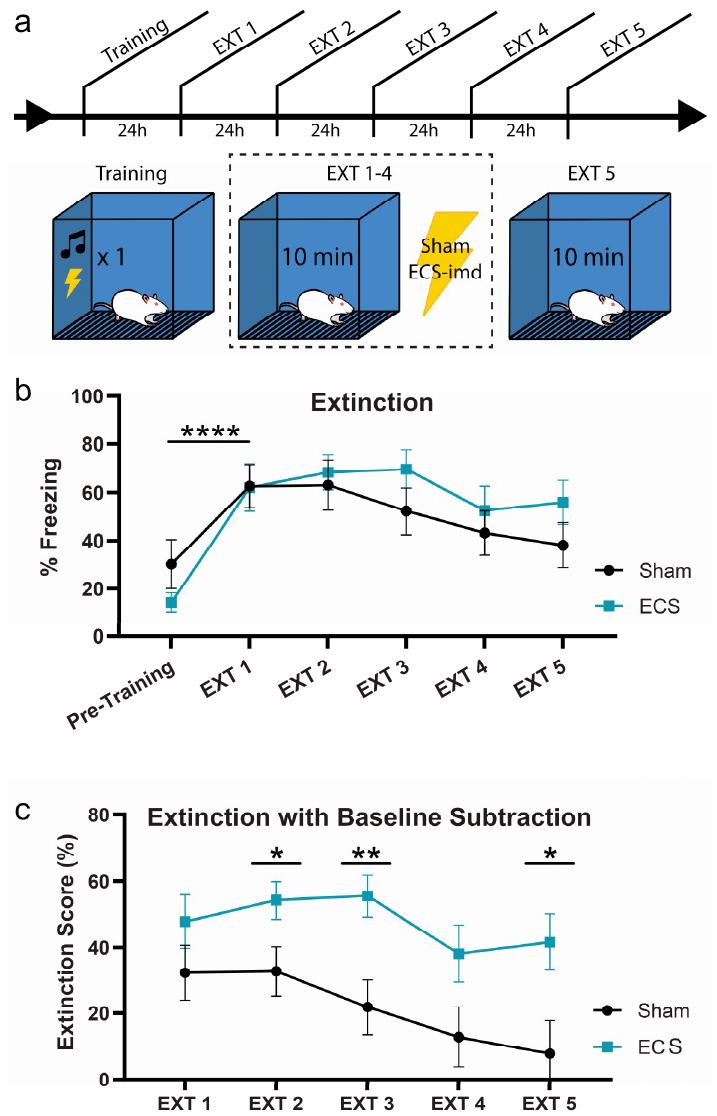
Figure 4. ECS may modestly impair extinction learning. ( a ) Schematic outline of experimental procedure testing the effects of ECS on extinction learning. ( b ) While both groups extinguish the fear memory, the sham group may extinguish the fear faster than the ECS group. This is indicated by a reduction in statistically significant differences between pre-training (baseline) and extinction session freezing. ( c ) Extinction data from ( b ) with baseline subtraction (extinction score) for the groups on each day indicate that the ECS group continues to show high levels of freezing across days, while the sham group displays a steady decrease to baseline freezing levels, such that the difference in fear extinction between the groups is significant at EXT 2, 3, and 5. * p < 0.05, ** p < 0.01, **** p < 0.0001, error bars = SEM. “Pre-training” is defined as the context acclimation period during training, prior to delivery of the tone-shock pairing.